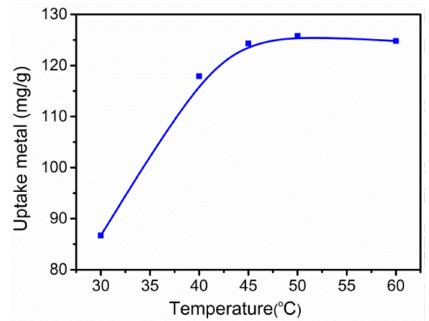
Figure 2. Effect of temperature of the grafting reaction on Pb(II) removal and q e . (Reaction